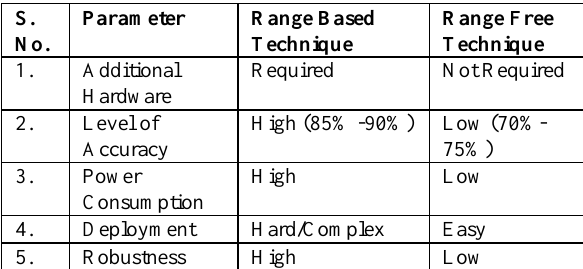
Table 1 Summary of localization